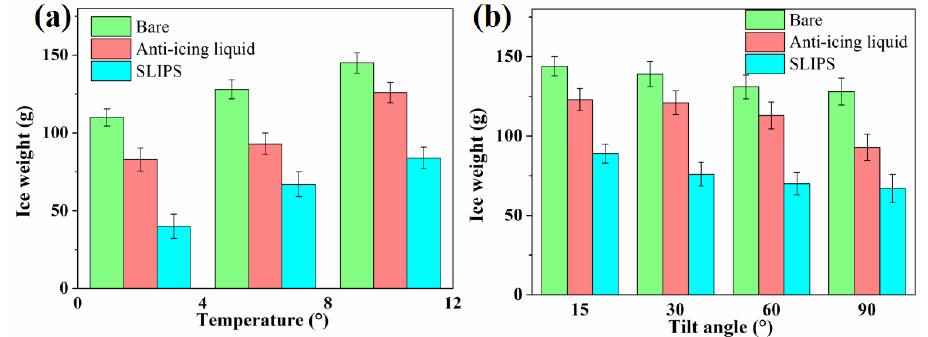
Figure 9. Ice weight of the bare aluminum surface and anti-icing-fluid-coated sample at different temperatures ( a ) and tilting angles ( b ).